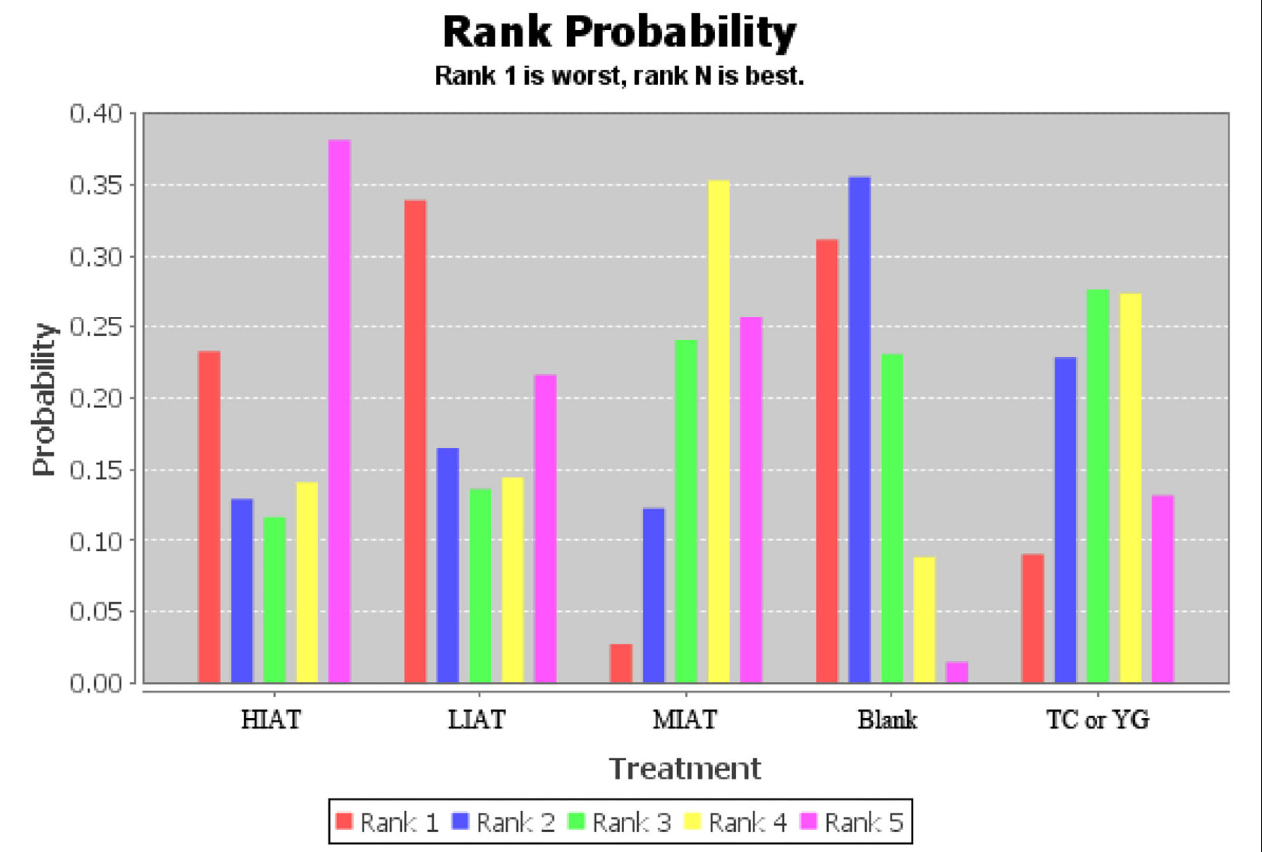
FIGURE 4 | Measurement of malondialdehyde (MDA) and ranking of intervention probability. Blank, Blank control; HIAT, High intensity aerobic training; MIAT, Medium intensity aerobic training; LIAT, Low intensity aerobic training; TC or YG, Tai Chi or Yoga.